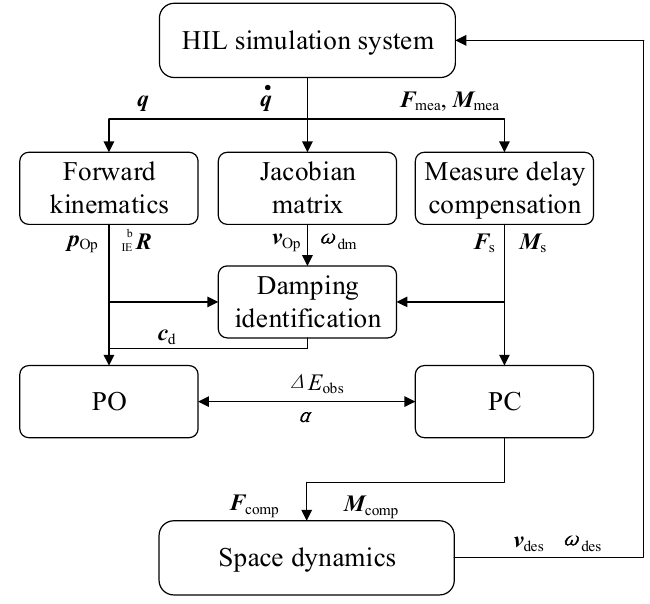
Figure 9. Control architecture.